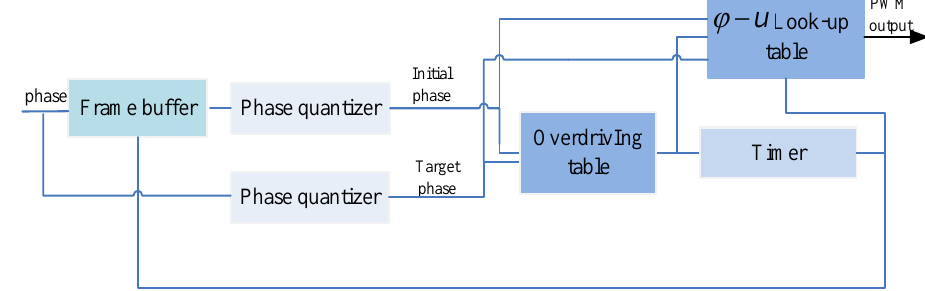
Figure 4. Implementation of Field-Programmable Gate Array overdriving system.